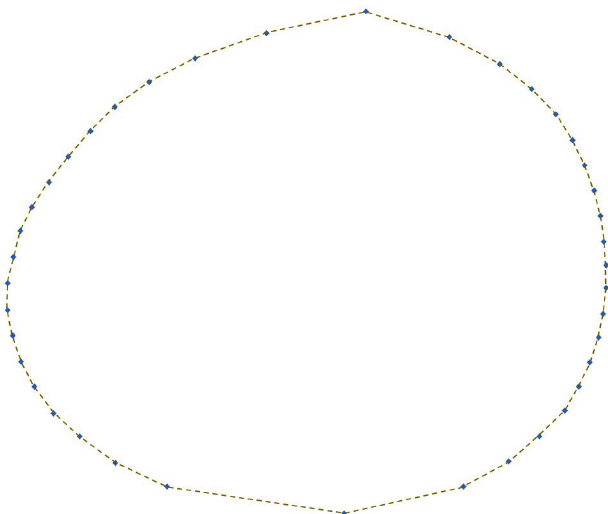
Figure 4. Mean overall shell outline shape of the four adult specimens of P. subtruncatum . The mean shape was generated from semilandmarks coordinates of the right valves using the